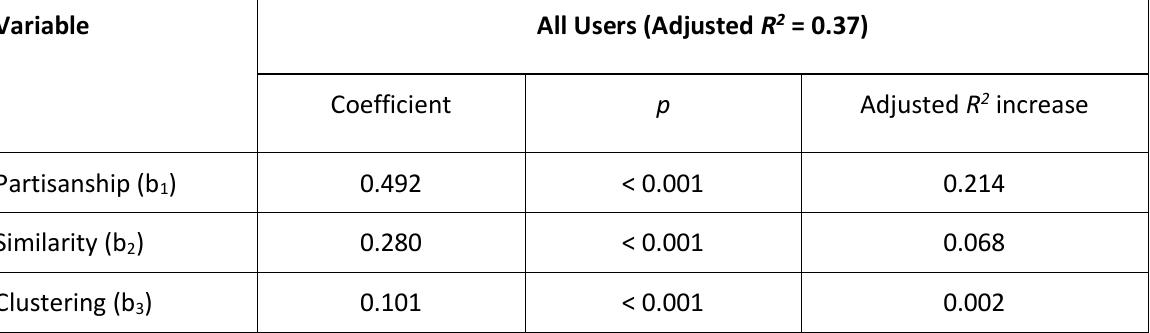
Table 2. Regression results: effects of the three independent variables on the vulnerability to online misinformation for all users. Along with the coefficients, we show p-values and adjusted R 2